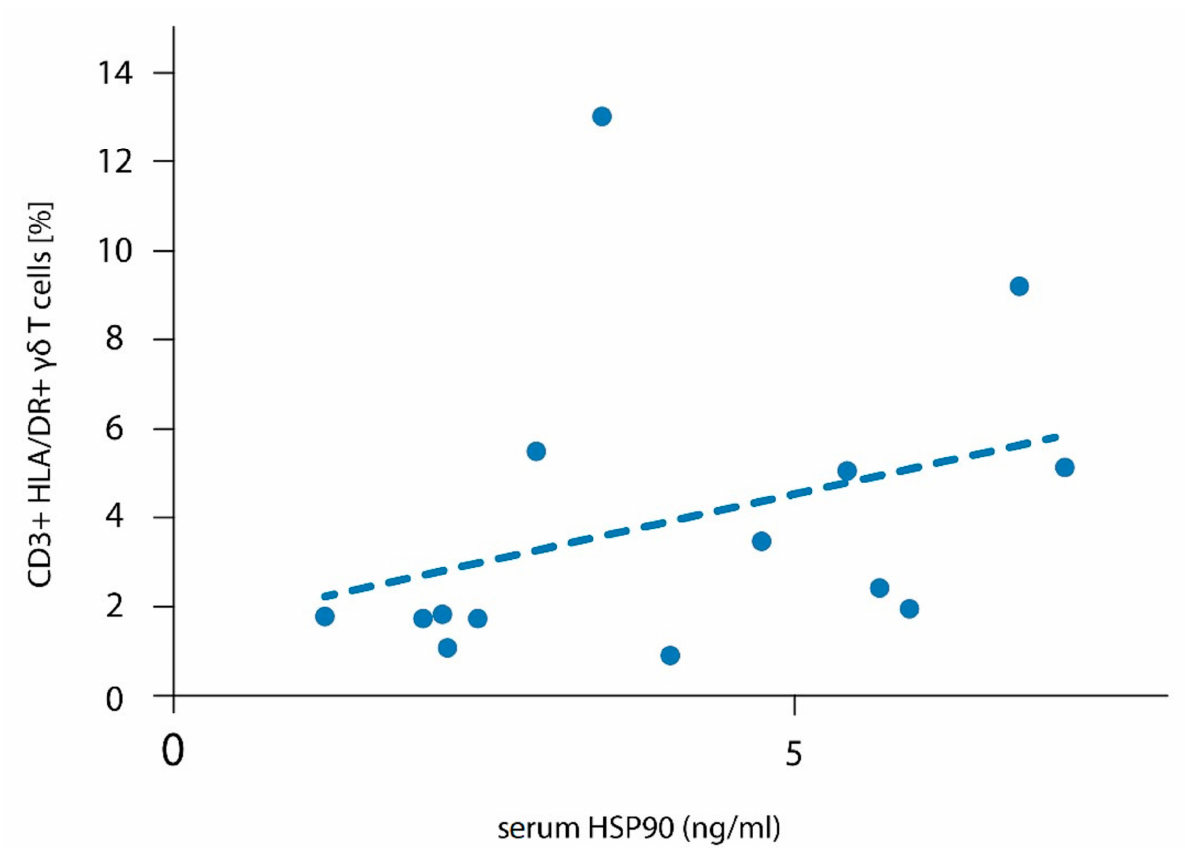
Figure 1. Correlation of activated serum HSP90 and CD3 + γδ T cells among children with ALL at diagnosis. The median CD3+ HLA/DR+ γδ T cells on the day of the diagnosis was 2.36% (range 0.91–13.00%), and 4.96% (range 0.88–55.17%) on the 33rd day of therapy. Median